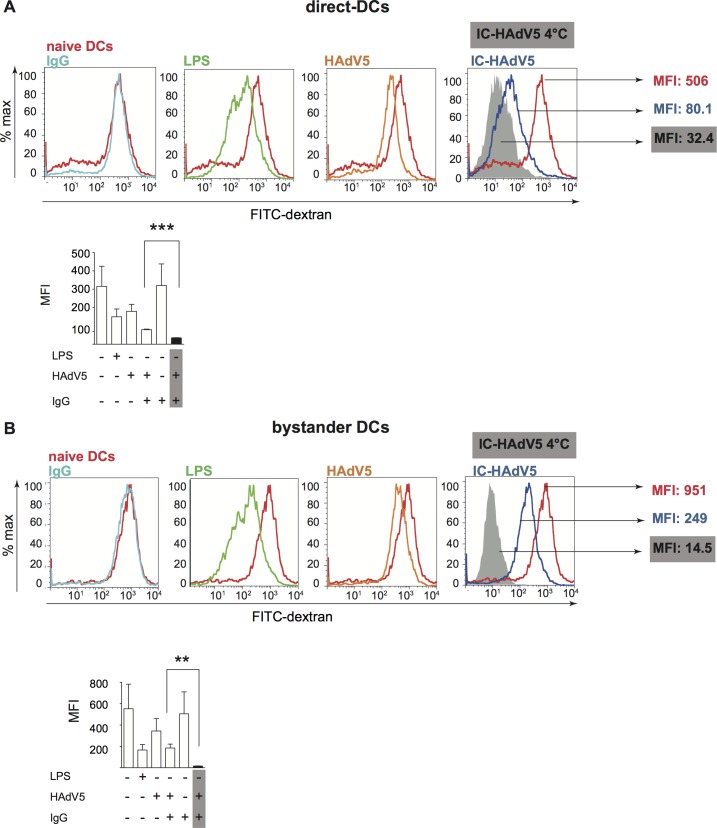
Fluid phase uptake by direct and bystander DCs.Fluid phase antigen uptake by direct and bystander DCs was quantified using FITC-labeled dextran and flow cytometry. A) Representative flow cytometry profiles and cumulative data of direct DCs challenged with LPS, HAdV5, IgG, or IC-HAdV5 and B) Representative flow cytometry profiles and cumulative data of bystander DCs with the corresponding direct DC milieu. Nonspecific binding of dextran to cells was controlled by incubation at 4°C (S7 Fig). MFI–median fluorescent index; n = 3 donors, in duplicate.